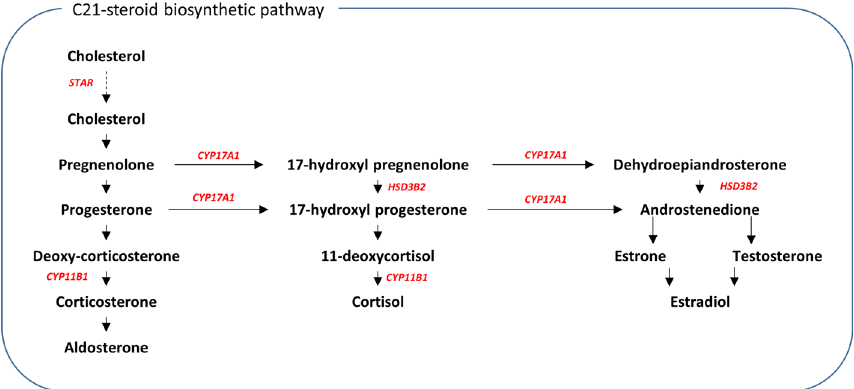
Figure 6. Schematic of part of C21-steroird biosynthesis pathway. Genes shown in red were associated with a significant increase in variability in individuals homozygous for the rs1105995 risk allele (A) in breast tissue (i.e. 4 of the 70 breast-derived genes from Fig. 4).